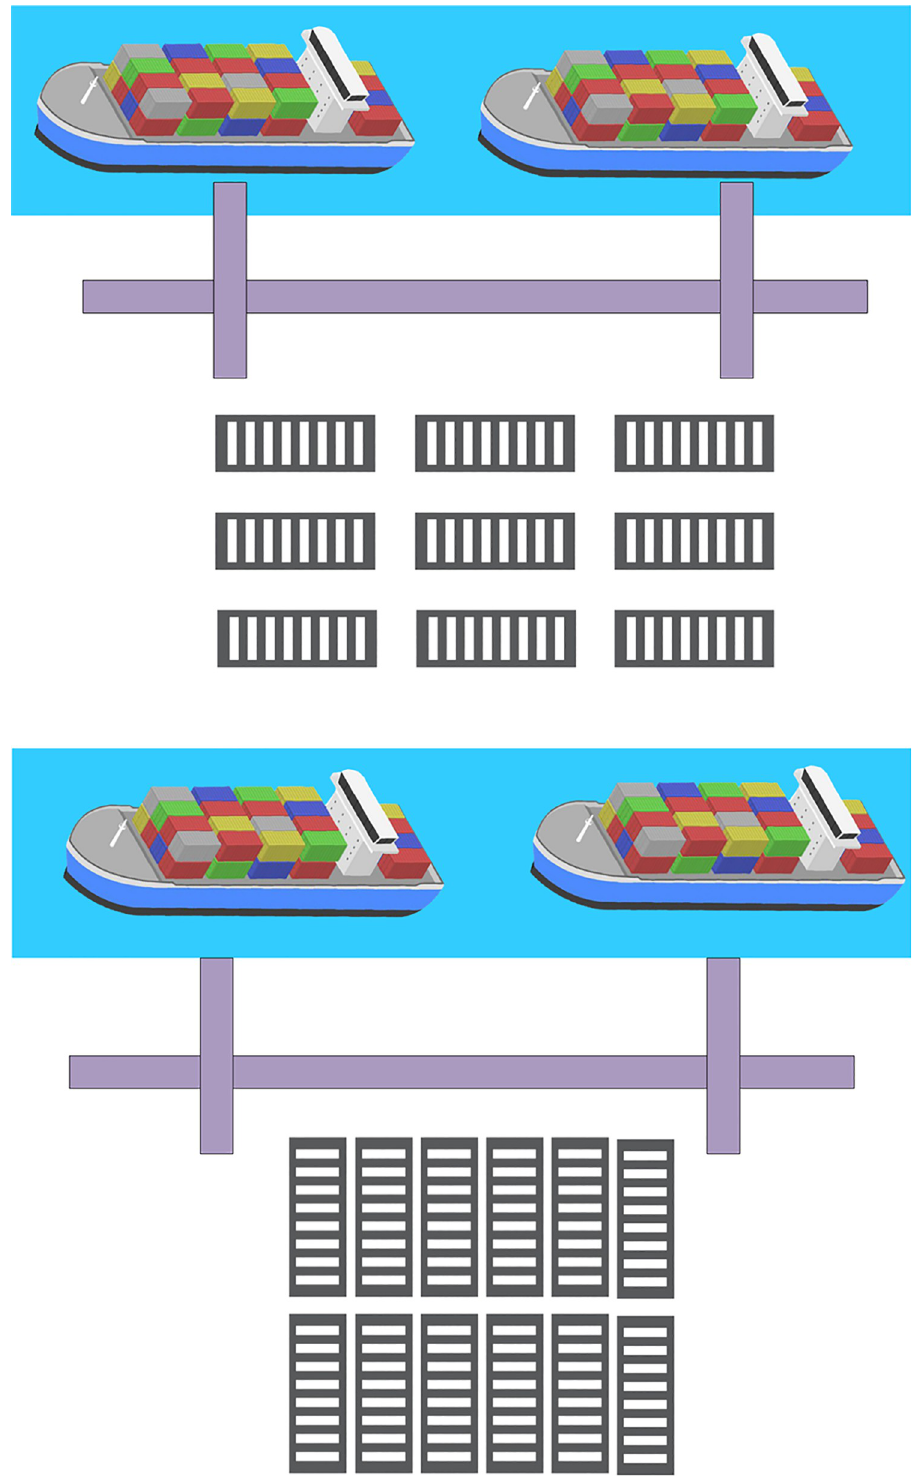
Fig 2. CT yard layout. (a) Coastal layout: (b) Vertical